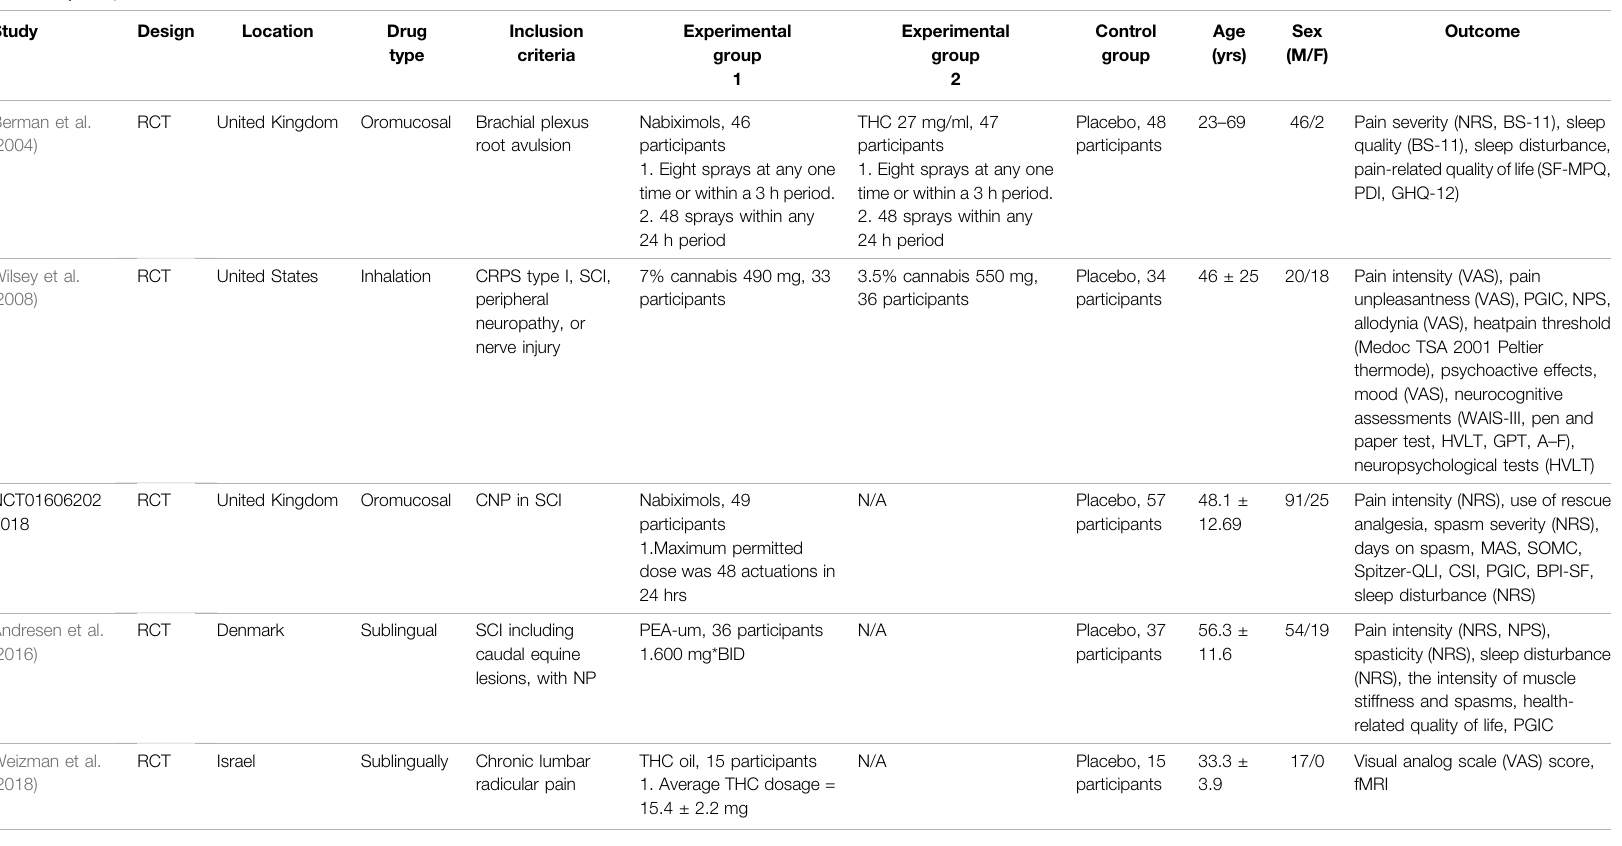
TABLE 1 | Study characteristics of the included